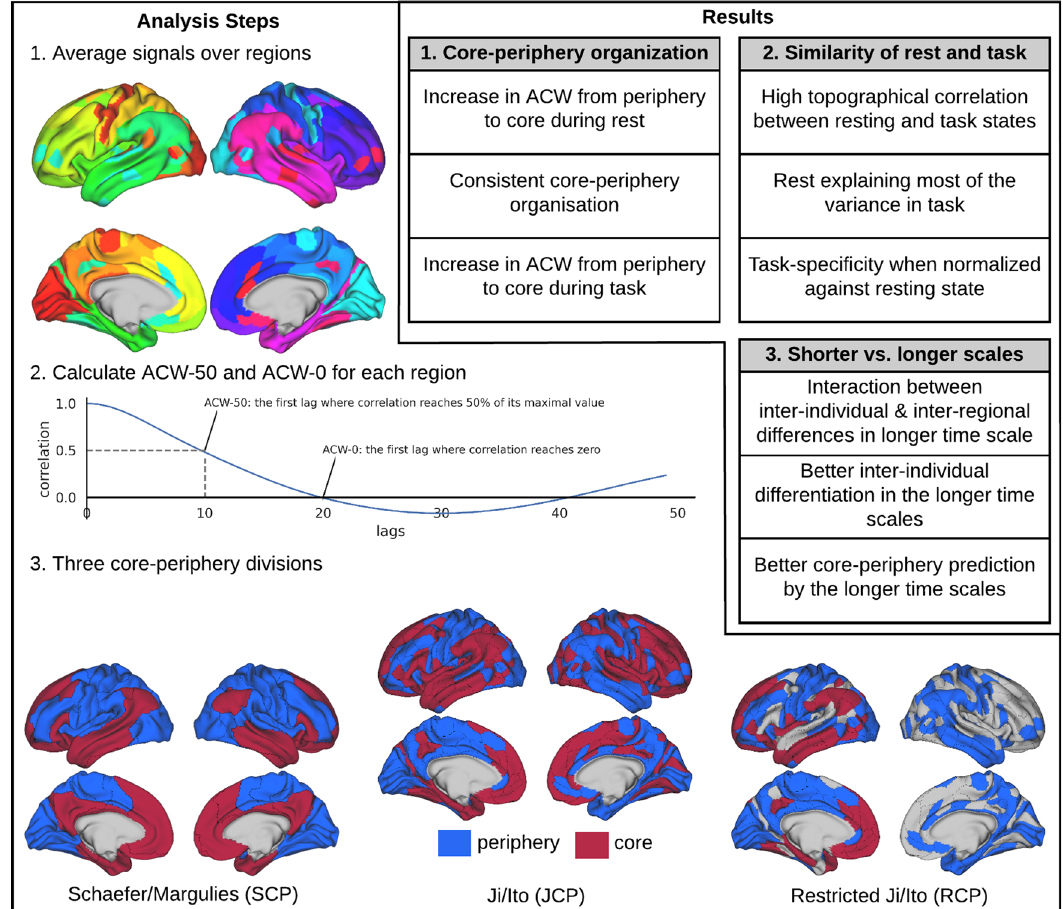
Fig. 1 Schema of the paper. Represents the primary analysis conducted in this study. First, the time-series were averaged over cortical brain regions (1). Then, ACF was calculated for each region and from that ACW-50 and ACW-0 were extracted (2). Three different core – periphery divisions were de fi ned based on the Schaefer and Ji templates (3). In Schaefer/Margulies (SCP) core-periphery division, cortical regions/networks are de fi ned based on the Schaefer template 40 and then divided into core or periphery based on the fi rst principal gradient introduced in ref. 14 . The regions/networks in Ji/Ito (JCP) are from Ji template 41 and each region is labelled core or periphery based on unimodal/transmodal de fi nition in ref. 1 . The periphery de fi nition in Restricted Ji/Ito (RCP) is similar to JCP, but only the regions in cingulo opercular, frontoparietal and default-mode networks are assigned to the core division, and the rest of the regions are